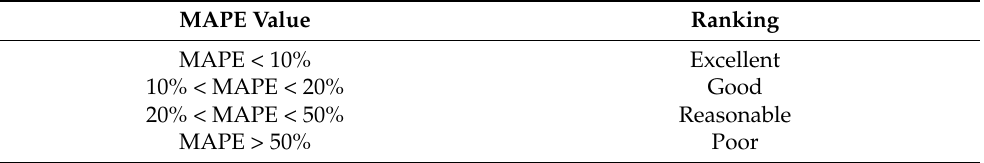
Table 2. The parameters of the mean absolute percent error (MAPE)